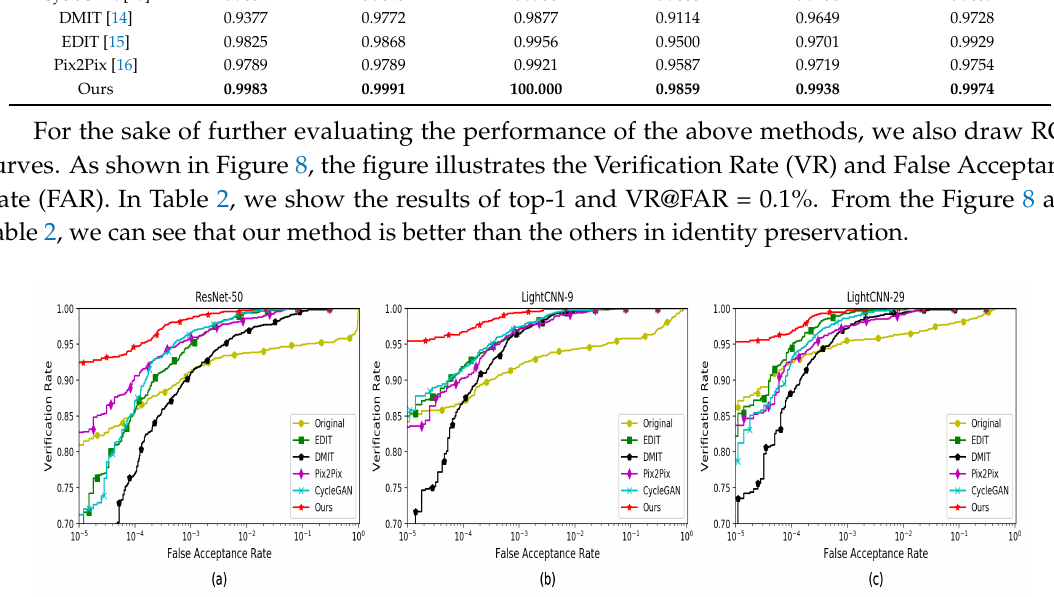
Figure 8. The ROC curves of face verification using ResNet-50, Light-CNN-9 and Light-CNN-29 on the MultiPIE dataset. ( a ) ROC curves of ResNet-50; ( b ) ROC curves of Light-CNN-9; ( c ) ROC curves of